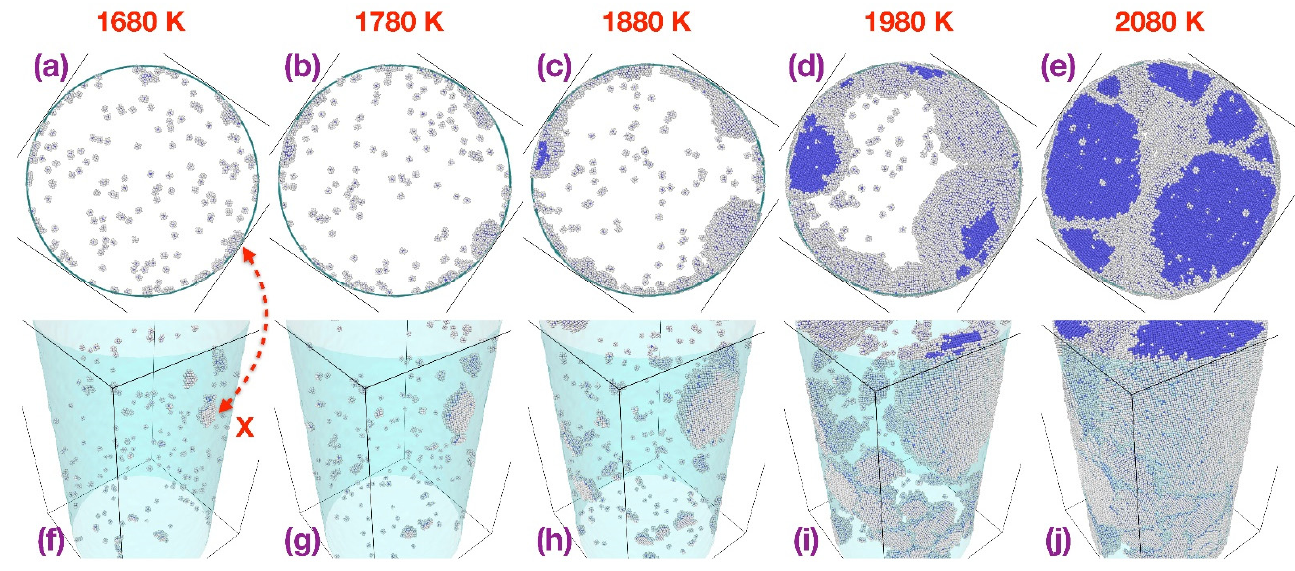
Figure 1. Spatial distribution of BCC (blue colored) and BCC shell (gray colored) atoms in the 25 nm diameter MG nanorod at different temperatures during the simulated heating process. The matrix (supercooled liquid) atoms are made invisible. Upper row ( a–e ): top view (orthogonal projection). Lower row ( f–j ): side view (perspective projection).